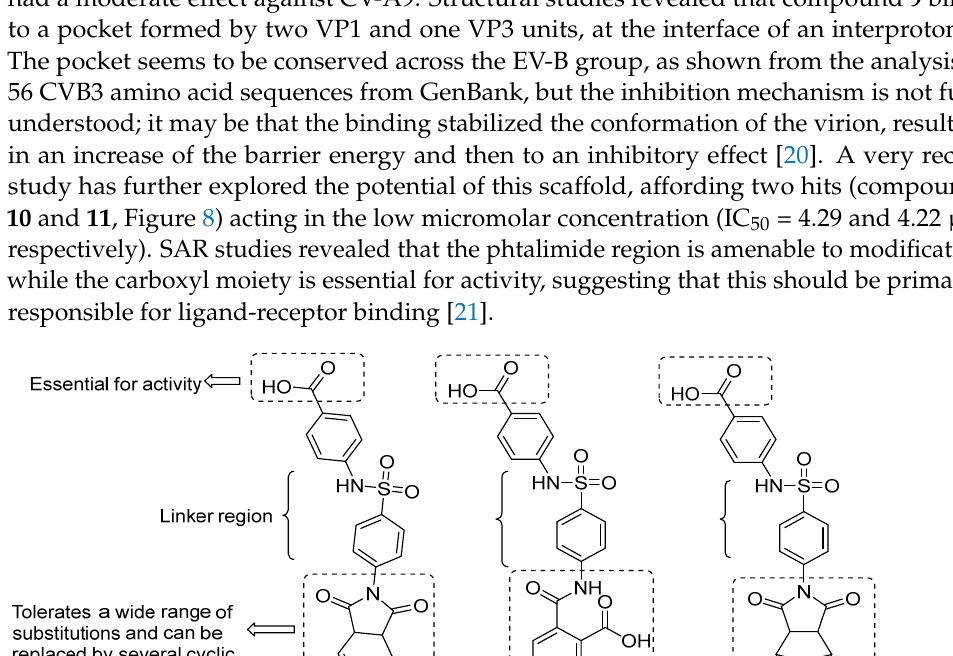
Figure 7. Chemical structures and activities against CVB3 and CVB4 of 4EDMAB and compounds